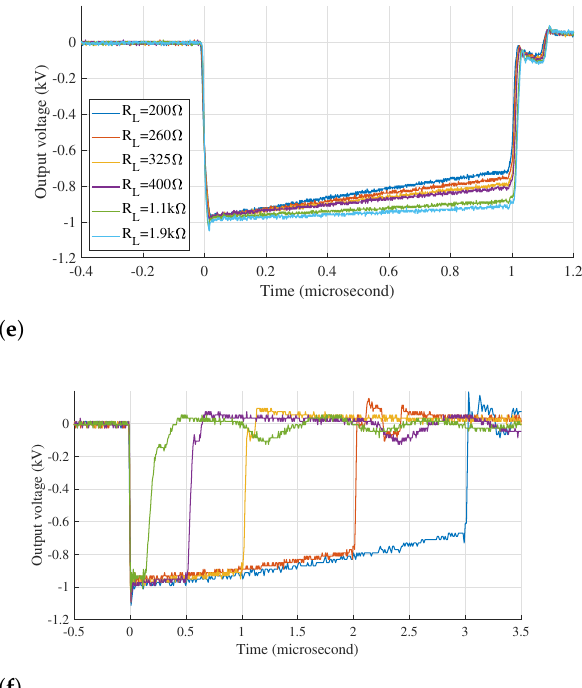
Figure 10. Experimental results. ( a ) View of experimental setup. ( b ) The 1 kV Output waveform for 500 ns pulse and 1 k Ω load. ( c ) Zoom of the rising edge of the pulse. ( d ) Amplitude test. ( e ) Load test. ( f ) Pulse-width